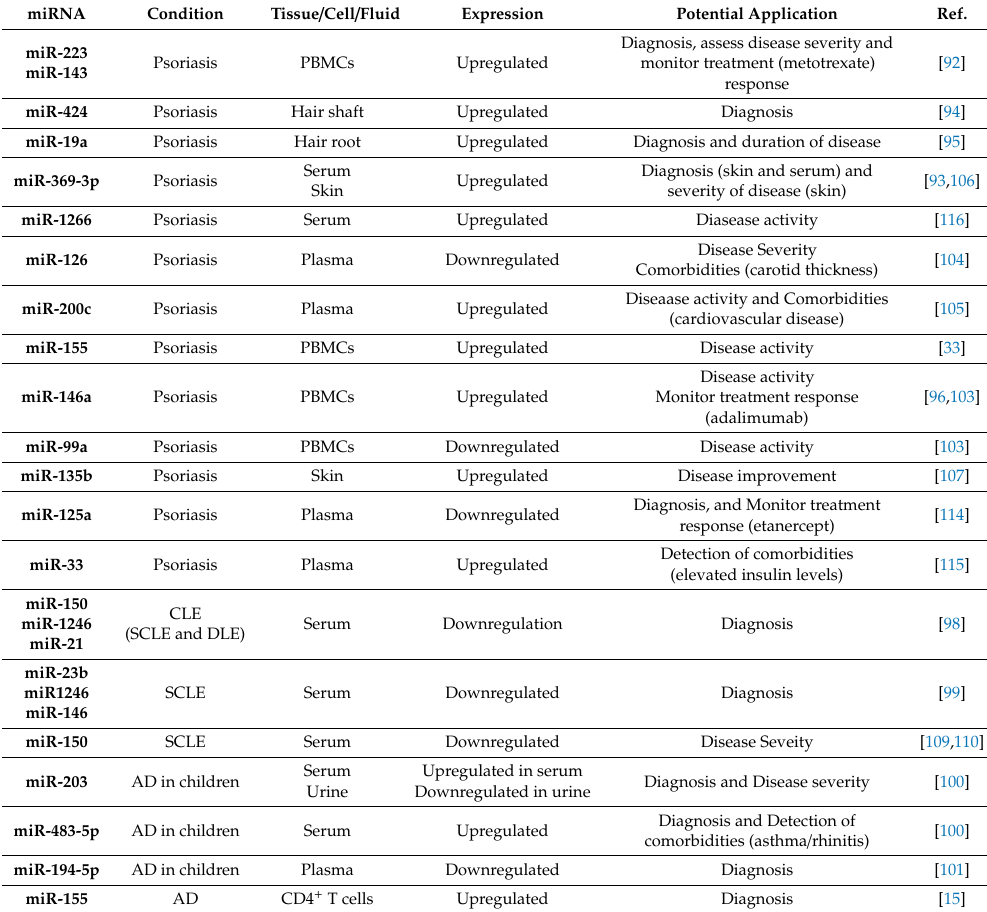
Table 2. miRNAs as biomarkers and potential applications in autoimmune skin conditions (psoriasis, cutaneous lupus erythematosus and atopic dermatitis). miRNA Condition Expression Potential Application